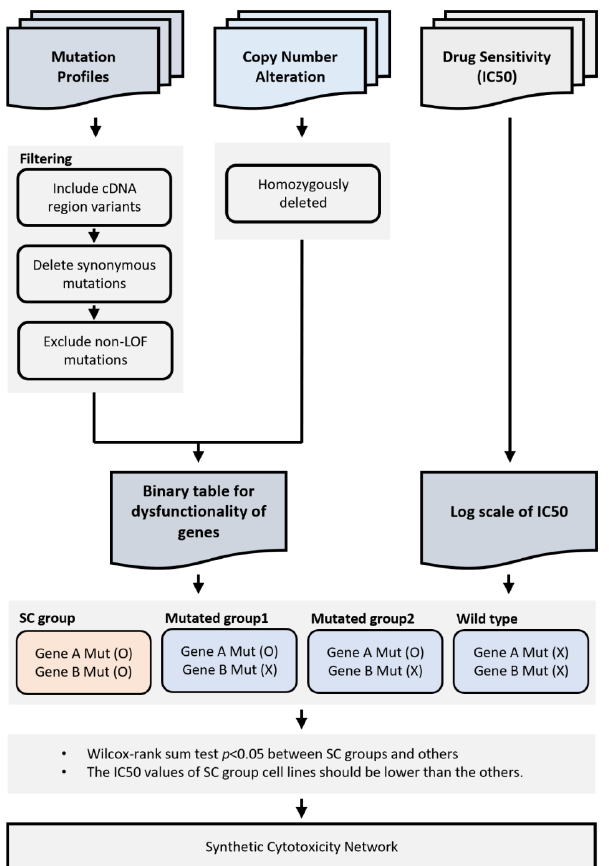
Figure 1. Workflow scheme for inferring synthetic cytotoxicity. All cancer cell lines were divided into four groups and defined based on the disruption of two genes. A synthetic cytotoxic pair is defined when both disrupted genes have significantly lower IC 50 than those in the other three groups.